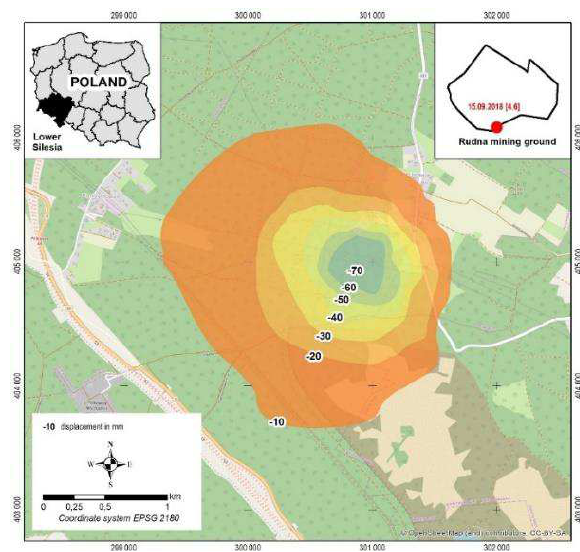
Figure 7. Map of the deformation resulting from the seismic event of 7 December 2017